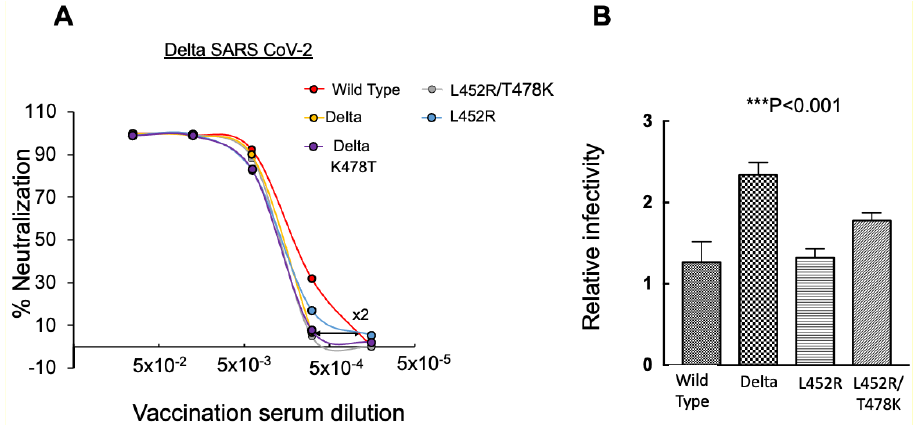
Figure 4. Infectivity levels and neutralization sensitivity of Delta SARS-CoV-2 and its unique RBD mutations. ( A ) Specific RBD residues of Delta spike that determine neutralization sensitivity to post vaccination sera-Neutralization assays were performed by transducing HEK293T-ACE2 cells with pseudoviruses displaying a wild-type SARS-CoV-2 spike or its specific Delta spike RBD single mutations, L452R, or T478K and double L452R/T478K. In addition, 48 h post transduction, cells were harvested and their luciferase readings were monitored. Neutralizing potency was calculated at increased serial dilutions, relative to transduced cells with no sera added. Neutralization, NT 50 , is defined as the inverse dilution that achieved 50% neutralization. Results are the average of two independent biological experiments. Triplicates were performed for each tested serum dilution. Black bars represent geometric mean of NT 50 values, indicated at the top. Statistical significance was determined using a one tailed t -test *** < 0.001. ( B ) Delta RBD spike mutations impact infectivity levels of SARS-CoV-2-Pseudoviruses bearing wild-type SARS-CoV-2 spike or the indicated Delta RBD spike mutations. Specific indicated pseudoviruses were used to transduce HEK293T-ACE2 cells. Equal viral loads were normalized based on p24 protein levels. In addition, 48 h post transduction, cells were harvested and their luciferase readouts were monitored. Bar graphs show mean values ± SD error bars of three independent